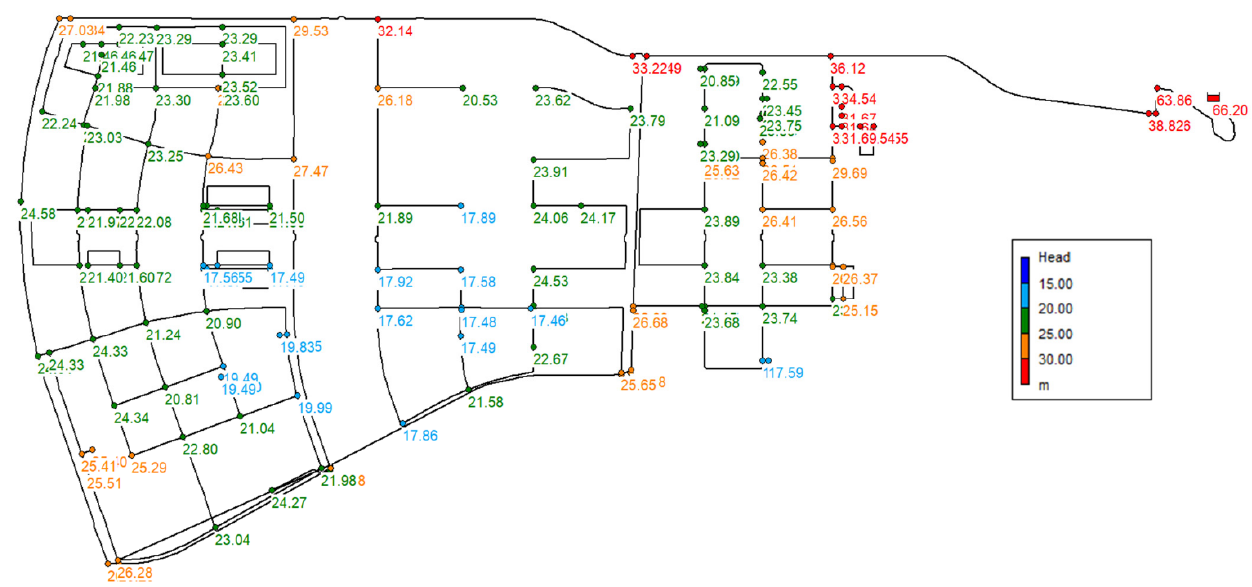
Figure 4. EPANET model of the Cheongna WDN, highlighting the optimal pipe diameters calcu- lated using the HS algorithm.